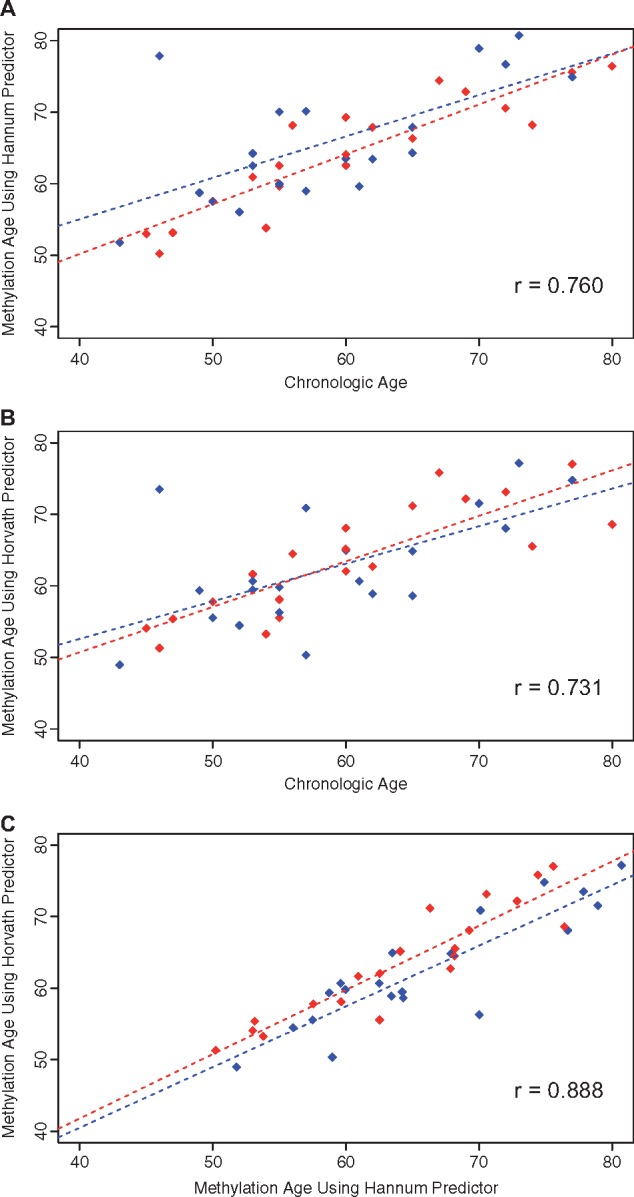
Hannum and Horvath Methylation Age (DNAm-age). Blue and red denotes LE (n = 20) and HE (n = 20) groups, respectively. Scatterplots are presented for Hannum DNAm-age vs. chronologic age (A), Horvath DNAm-age vs. chronologic age (B), and Horvath DNAm-age vs. Hannum DNAm-age (C). Spearman correlation coefficients are reported for entire study population (P < 0.0001 for each)